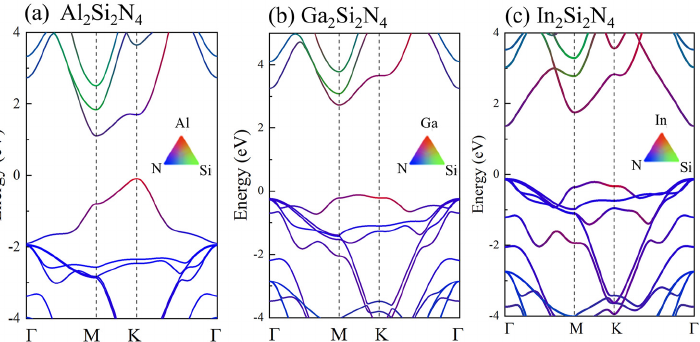
Figure 4. The projected electronic band structure and density of states (DOS) of ( a ) Al 2 Si 2 N 4 ,